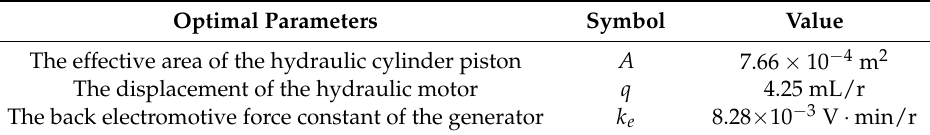
Table 1. Optimal